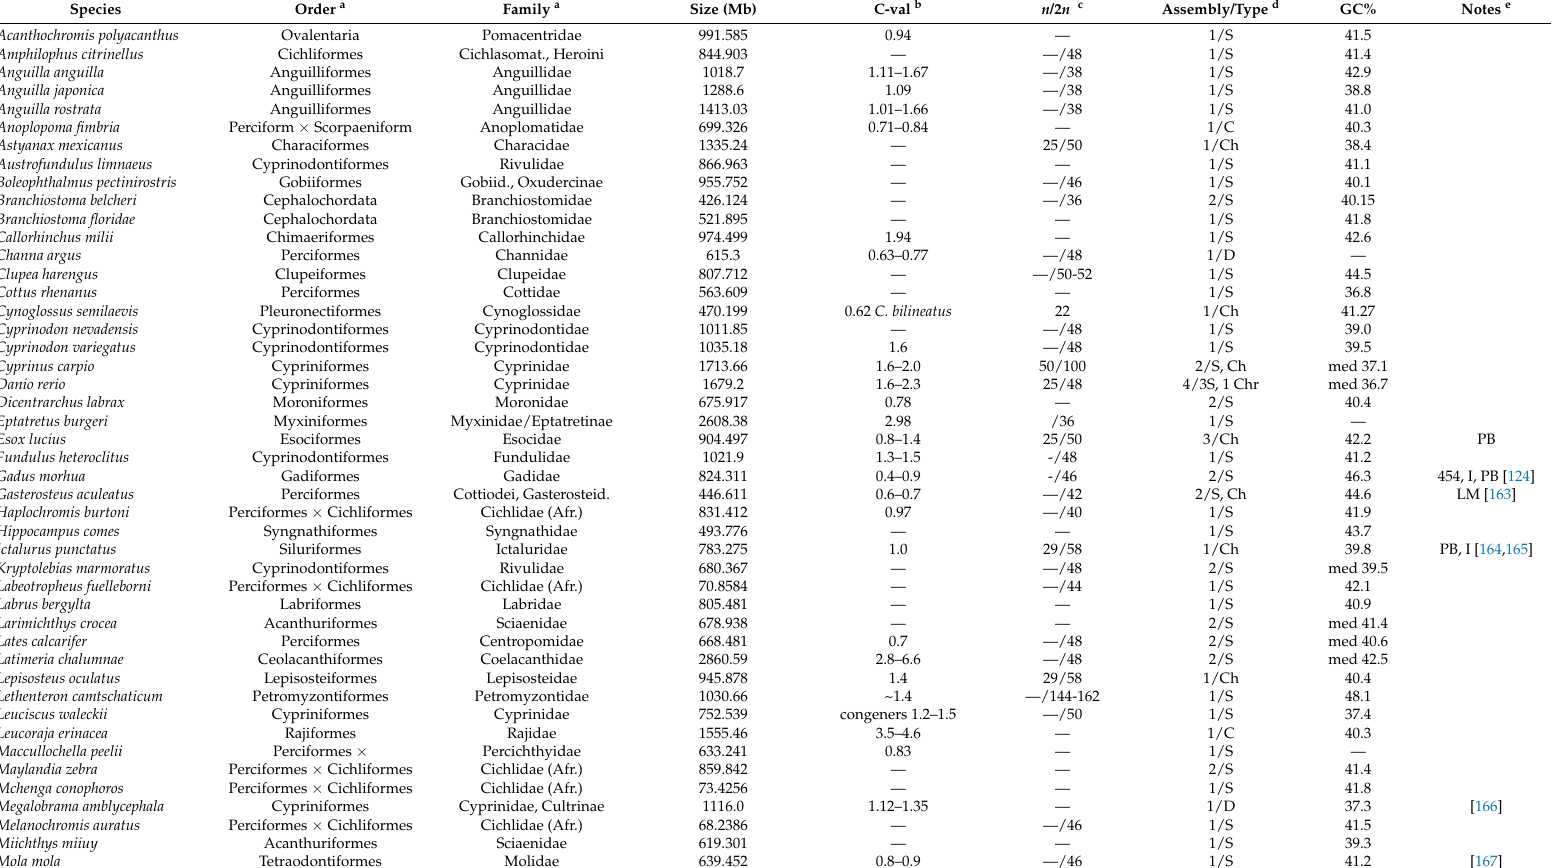
Table A1. Detailed overview of fish species with a sequenced genome. Diverse levels of genome assemblies (draft, contig, scaffold, fully assembled genomes to the chromosome level) and numbers of assembly versions are listed together with basic cytogenetic traits (2 n , C-value,